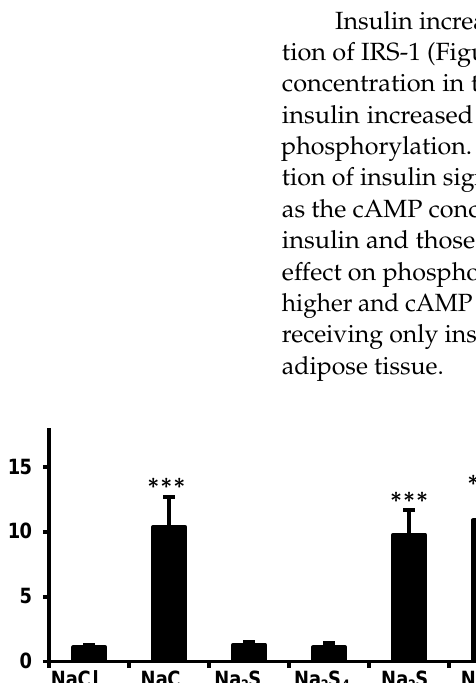
Figure 3. Effect of Na 2 S and Na 2 S 4 (both at 100 μmol/kg) administered 15 min before insulin (0.5